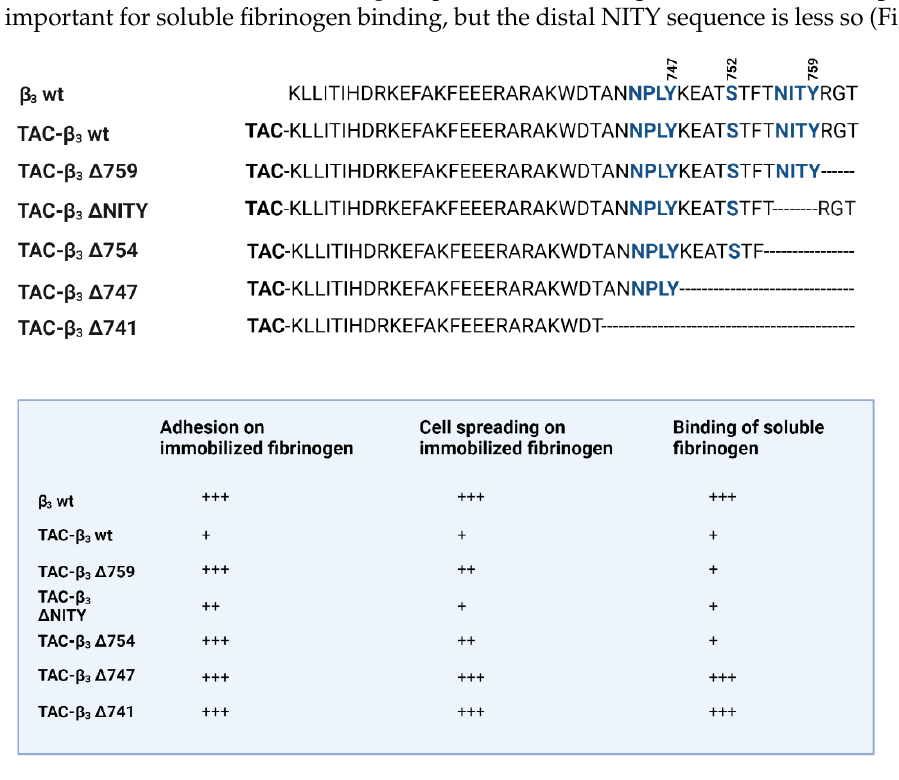
Figure 3. The cytoplasmic tail of the integrin β3 chain, and the effect of C -terminal deletions on the ability to induce trans-dominant inhibition of αIIbβ3 by the TAC - β3 integrin tail. The TAC - β3 construct completely inhibited adhesion and spreading on immobilized fibrinogen, and binding of soluble fibrinogen. The NITY deleted sequence also inhibited adhesion and spreading. C-terminal deletions up to T754 were able to inhibit the binding of soluble fibrinogen, but further shortenings were ineffective. The figure is adapted from ref. [56].